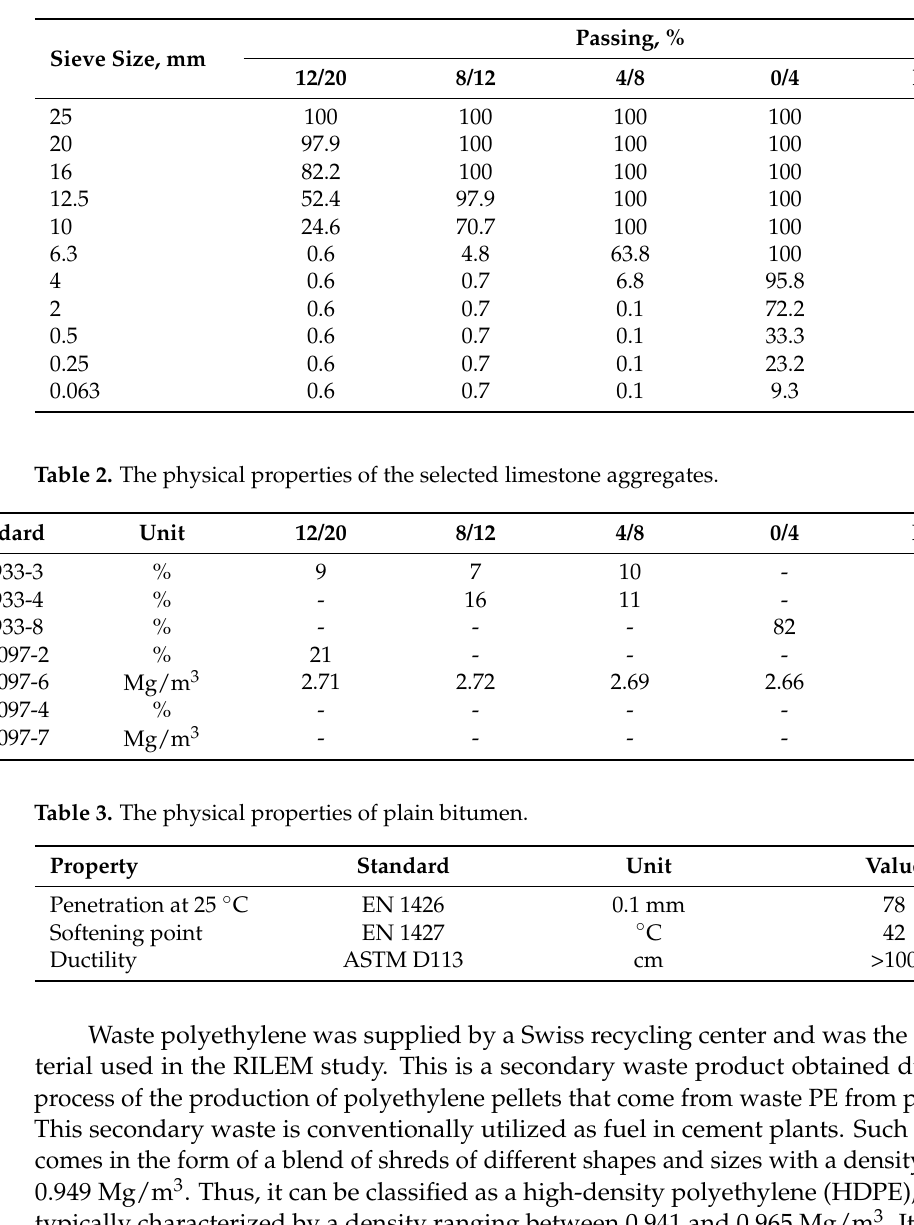
Table 1. The grade compositions of the available aggregates.